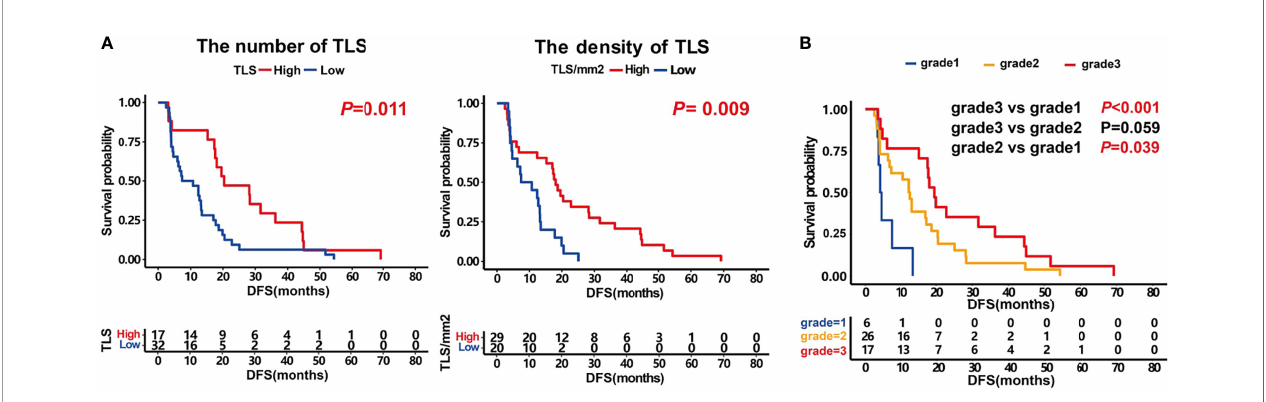
FIGURE 2 | Prognosis impact of the number and density of TLS and patients score. (A) Kaplan – Meier survival curves showing DFS according to the number of TLS ( P =0.011) and the density of TLS ( P =0.009). (B) Kaplan – Meier survival curves showing DFS according to patients score. P values were calculated by the log-rank